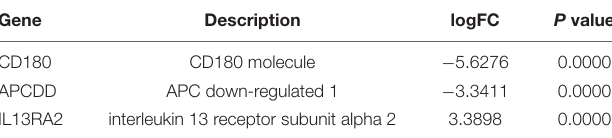
TABLE 1 | Main DEGs after vitreous